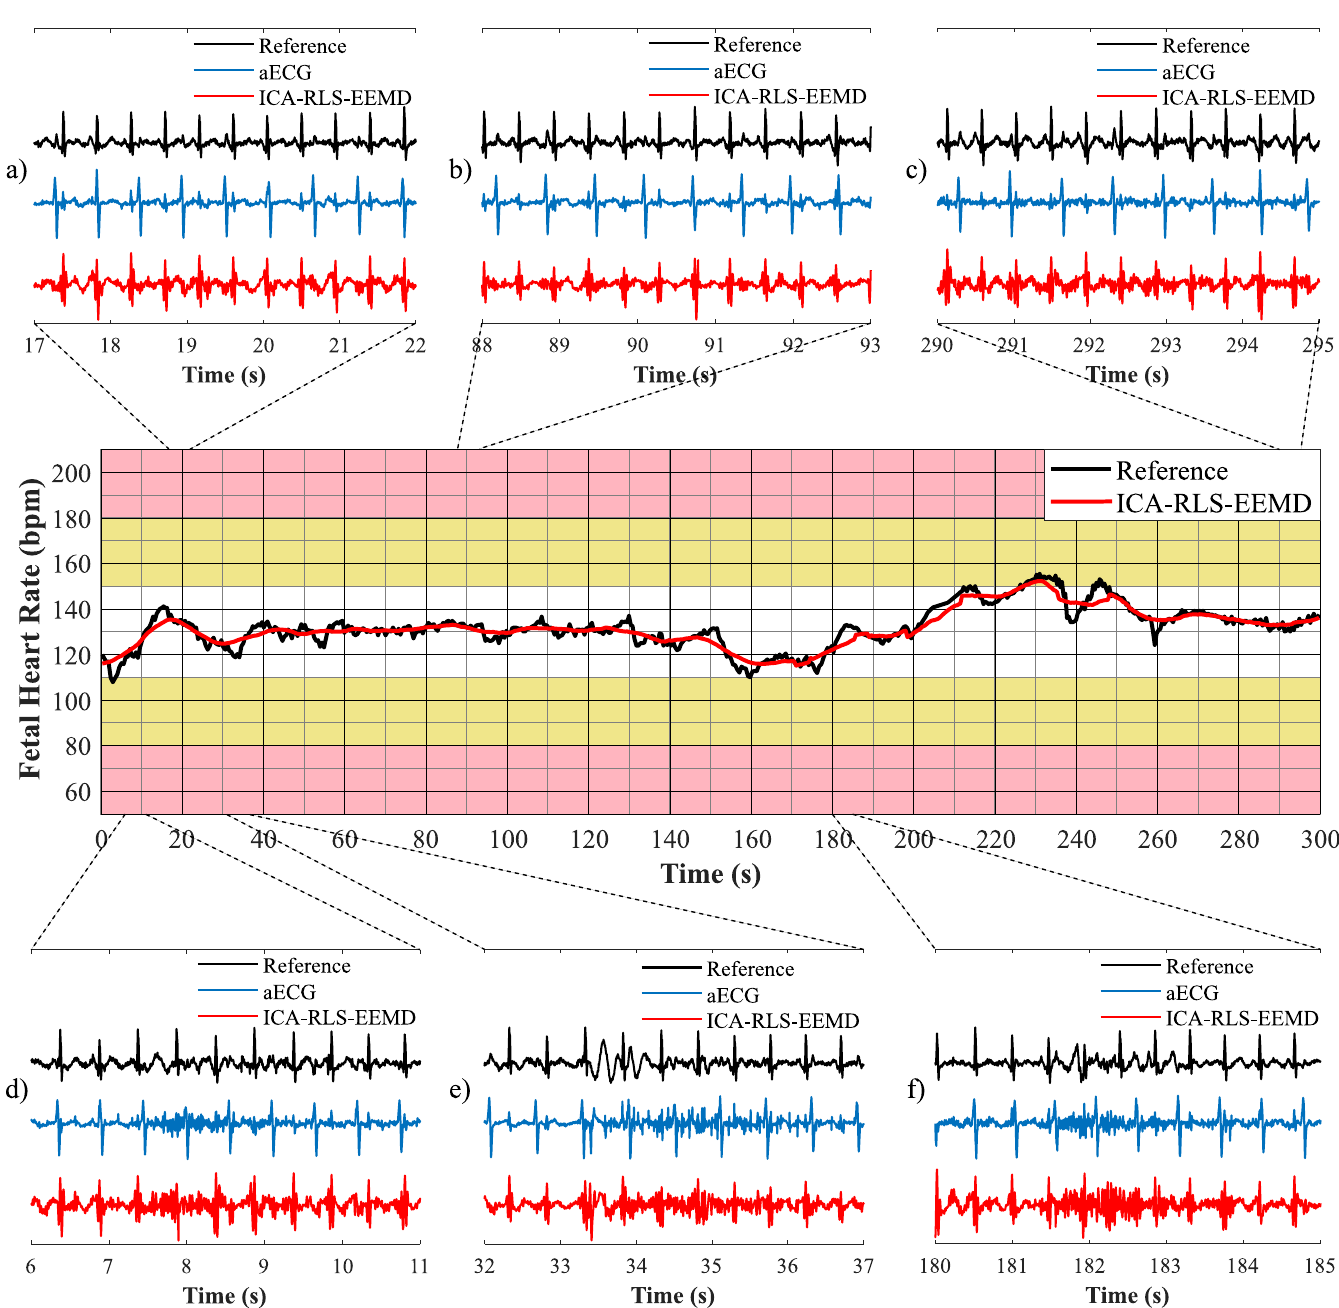
Fig 13. Illustration of the influence of the quality of aECG recordings on the final extraction and the fHR determination. As an example, the recording r10 from the FECGDARHA database was selected, which was characterized with the overall high-quality extraction. Traces obtained using the ICA-RLS-EEMD method are compared with the annotation. Examples a), b) and c) correspond to sections where high accuracy was achieved in the fHR determination, and examples d), e) and f) correspond to sections where the fHR determination was less accurate. devices with different resolutions, configurations and electrode placements. Large amount